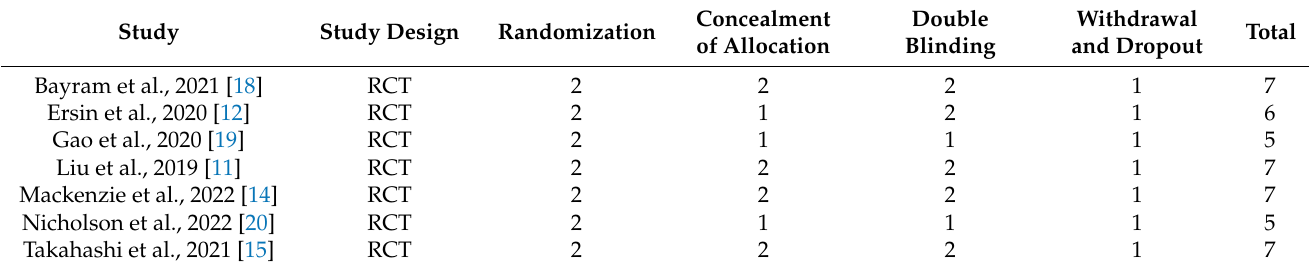
Table 2. Modified Jadad score.